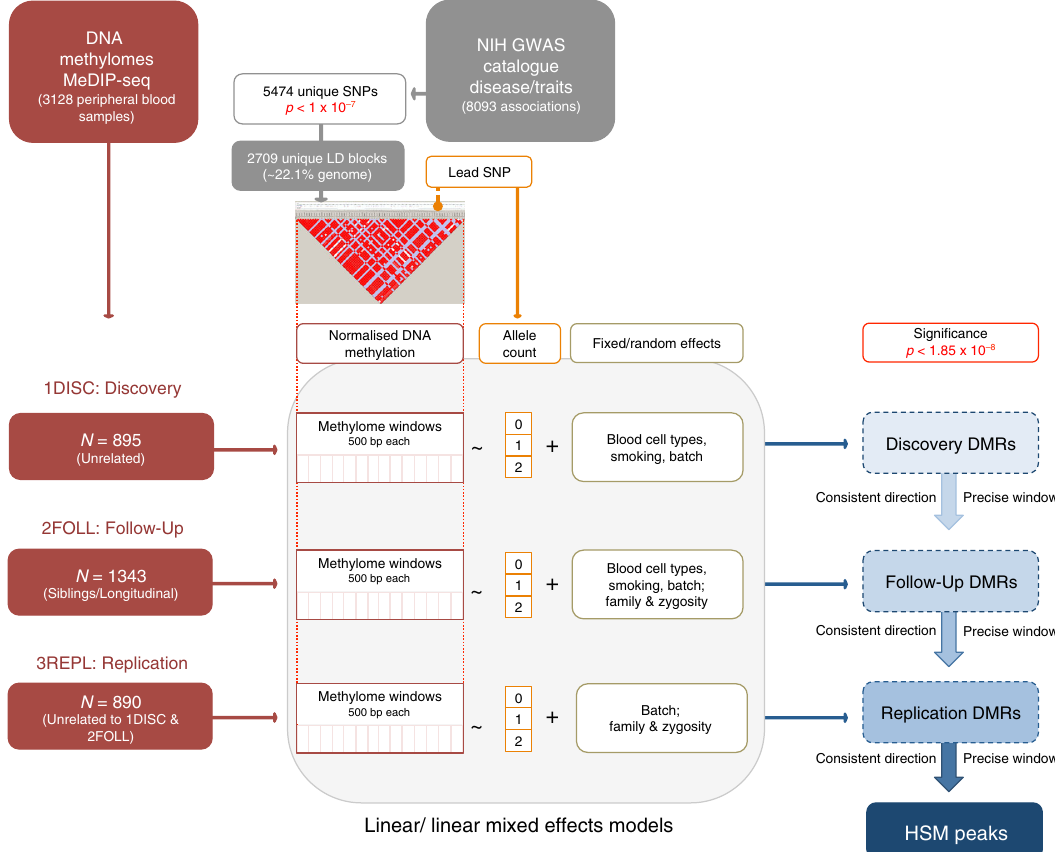
Fig. 1 Study design. Flowchart illustrating the three separate analyses performed then collated to fi nd consistent signi fi cant ( p < 1.85 × 10 − 8 , linear model, linear mixed model, see ‘ Methods ’ ) and directional changes in risk haplotype-speci fi c DNA methylation (HSM) peaks. The three data sets comprise: 1DISC ( n = 895), 2FOLL ( n = 1343) and 3REPL ( n =